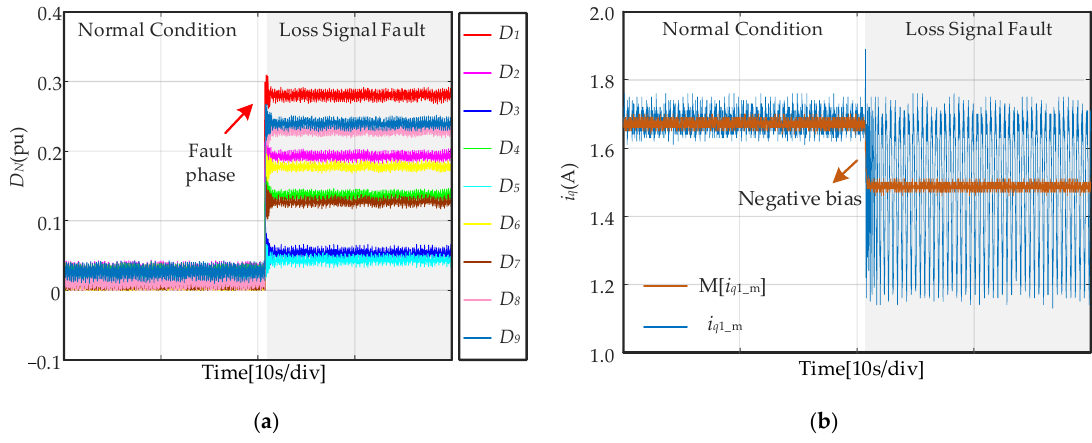
Figure 10. ( a ) M[| i α 1_ N |] in loss signal fault; ( b ) M[| i β 1_ N |] in loss signal fault. Figure 11 shows the diagnosis variables D N and M[i q1_m ]. In normal conditions, each D N are almost equal and approximately zero. When a current sensor fault occurs, the dif- ference between M[| i α 1_ N |] and M[| i β 1_ N |] of the fault phase is strictly maximum in Figure 10. Therefore, D 1 is the max value of nine D N , so the fault phase can be located. Moreover, i q 1_m has a negative DC bias “− I am sin( θ ori )/9” , a zero-mean pulse. Thus, M[ i q 1_ m ] in a loss signal fault is less than it is in normal conditions, so the loss signal fault of phase-A 1 cur- rent sensor can be diagnosed.